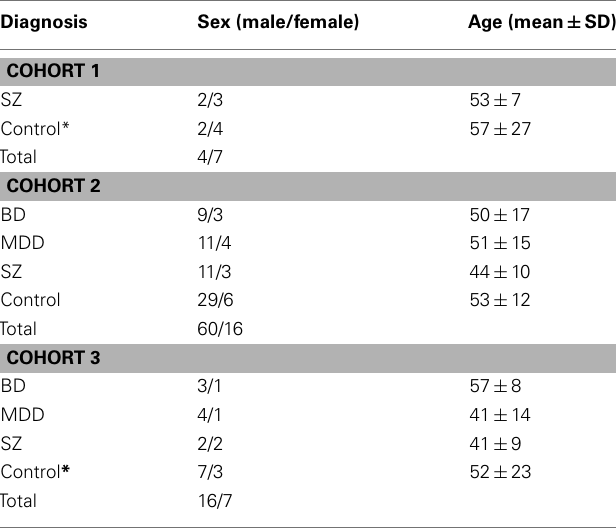
Table 1 | Clinical and demographic characteristics for cohorts 1, 2, and 3/cohort 1 ( n = 11) diagnosis and